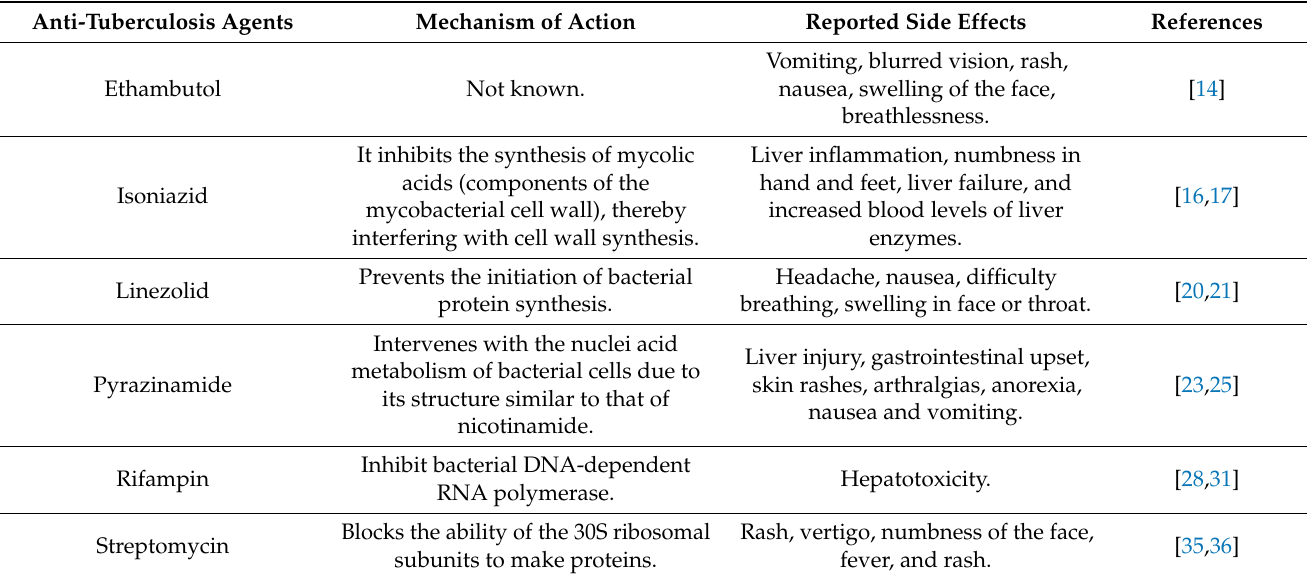
Table 1. Antituberculosis agents with their limitations in the treatment of